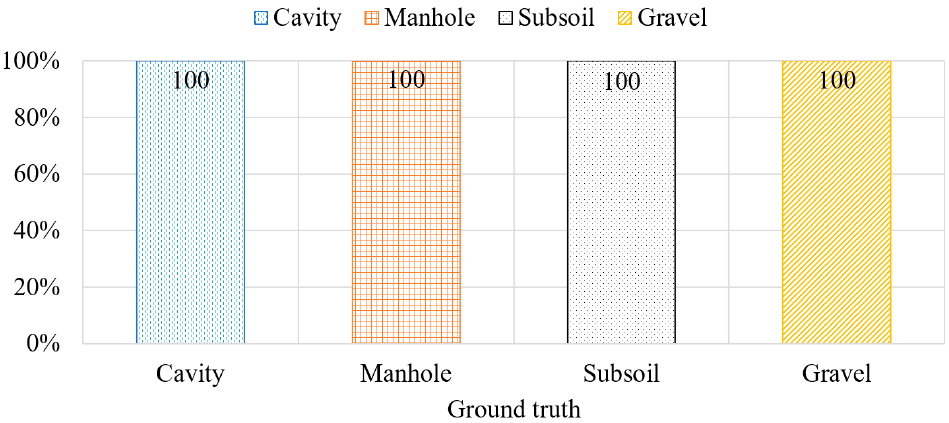
Figure 16. Updated underground object classification results using UcNet.